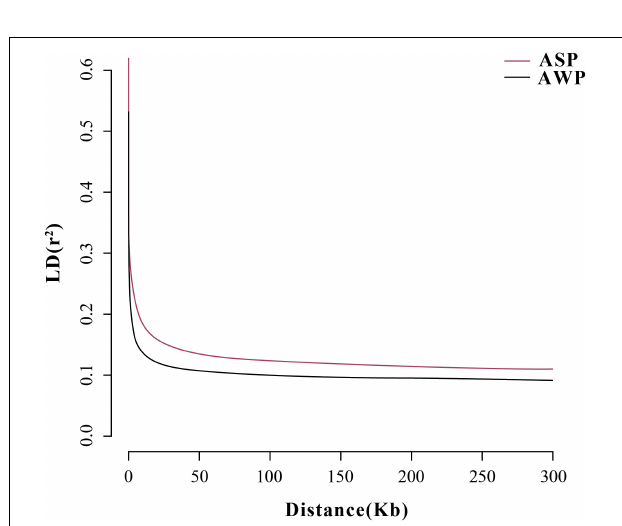
FIGURE 3 | Correlation coefficients ( r 2 ) were calculated for the Asian wild boar and Anqing six-end-white pig over 50-kb windows.